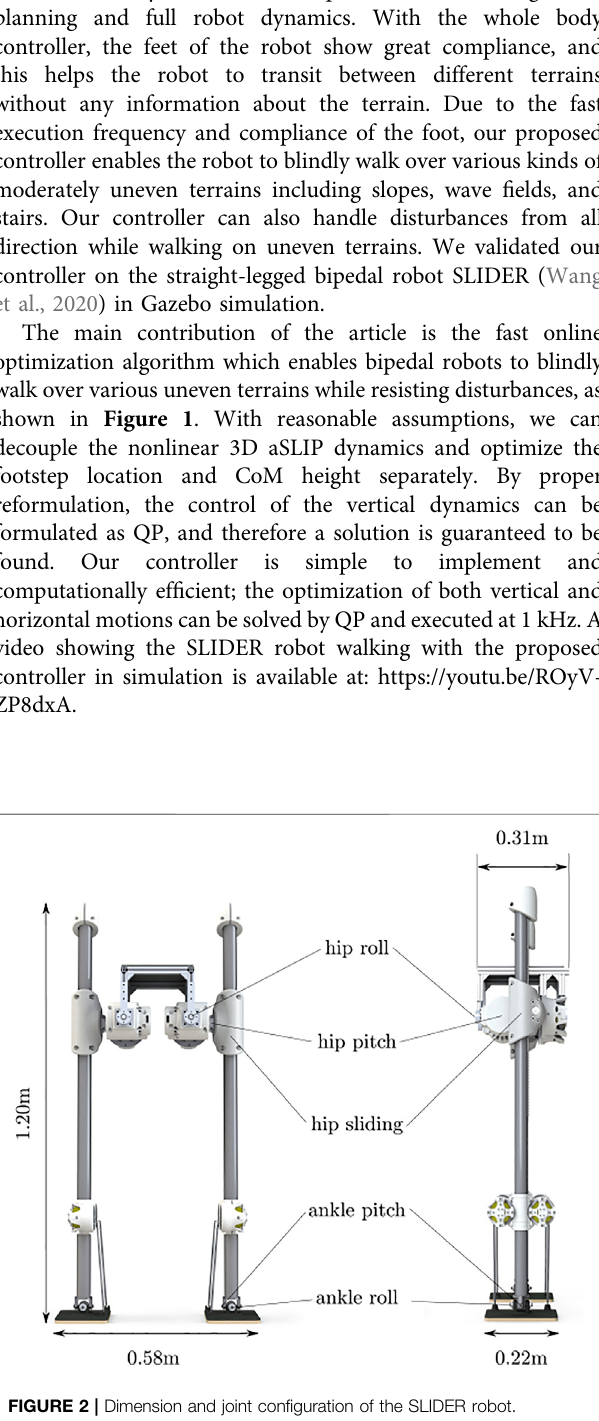
FIGURE 2 | Dimension and joint con fi guration of the SLIDER